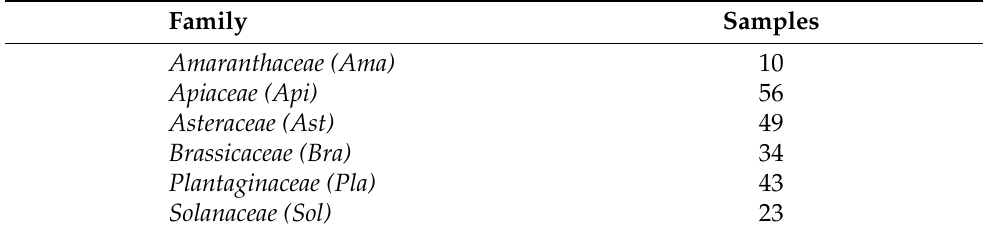
Table 3. Canada data set description: family name and number of samples.